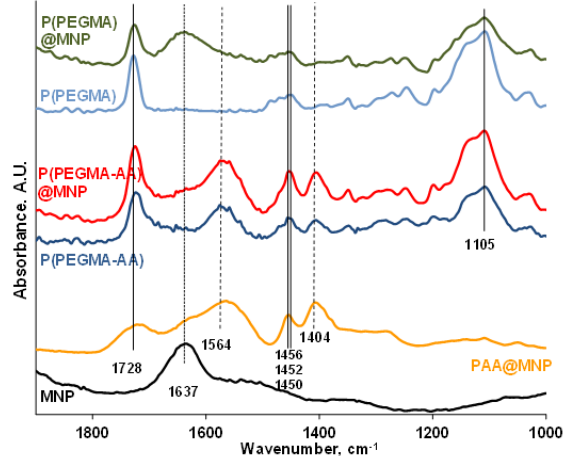
Figure 3. FT-IR absorption spectra of P(PEGMA-AA) and P(PEGMA) before and after adsorption on MNP in the range of 1000–1900 cm − 1 . The spectrum of PAA@MNP [37] are also plotted for comparison. The samples were dried from pH ~ 6.5 and I = 10 mM medium on ATR diamond crystal.